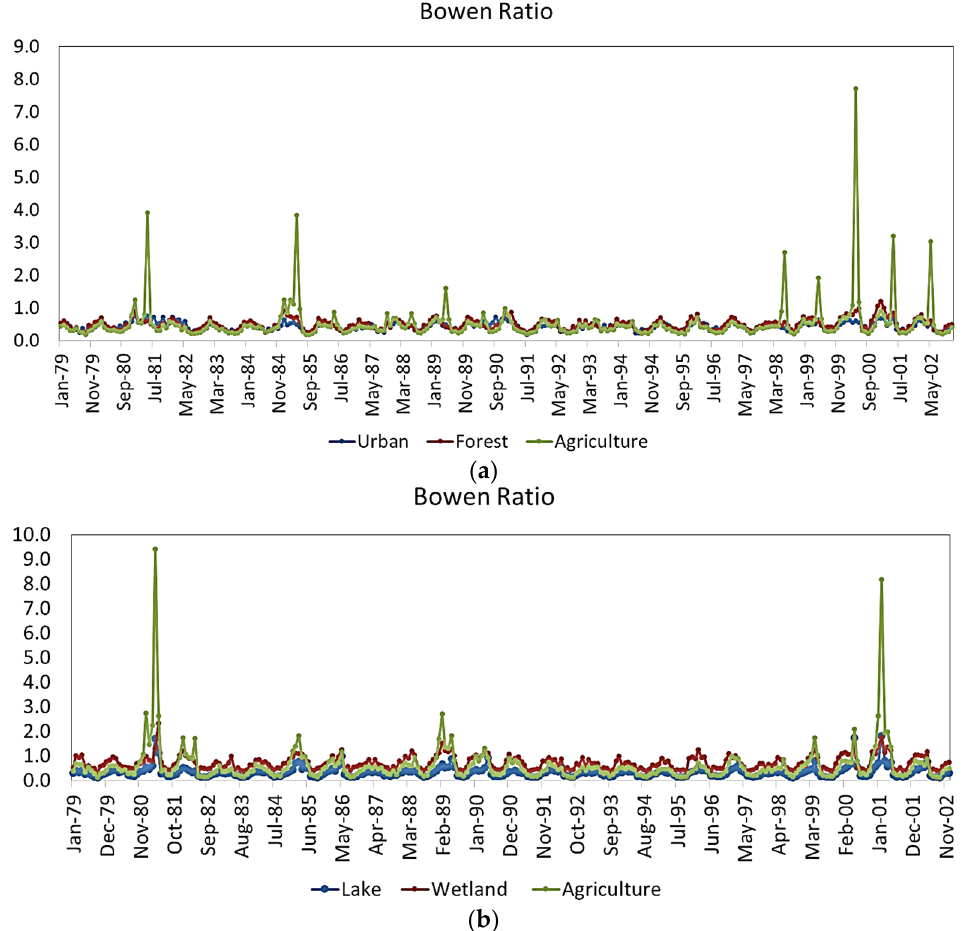
Figure 8. ( a ) Time Series for Monthly Bowen Ratio Patterns for Northeast Florida; ( b ) Time Series for Monthly Bowen Ratio Patterns for South Florida.